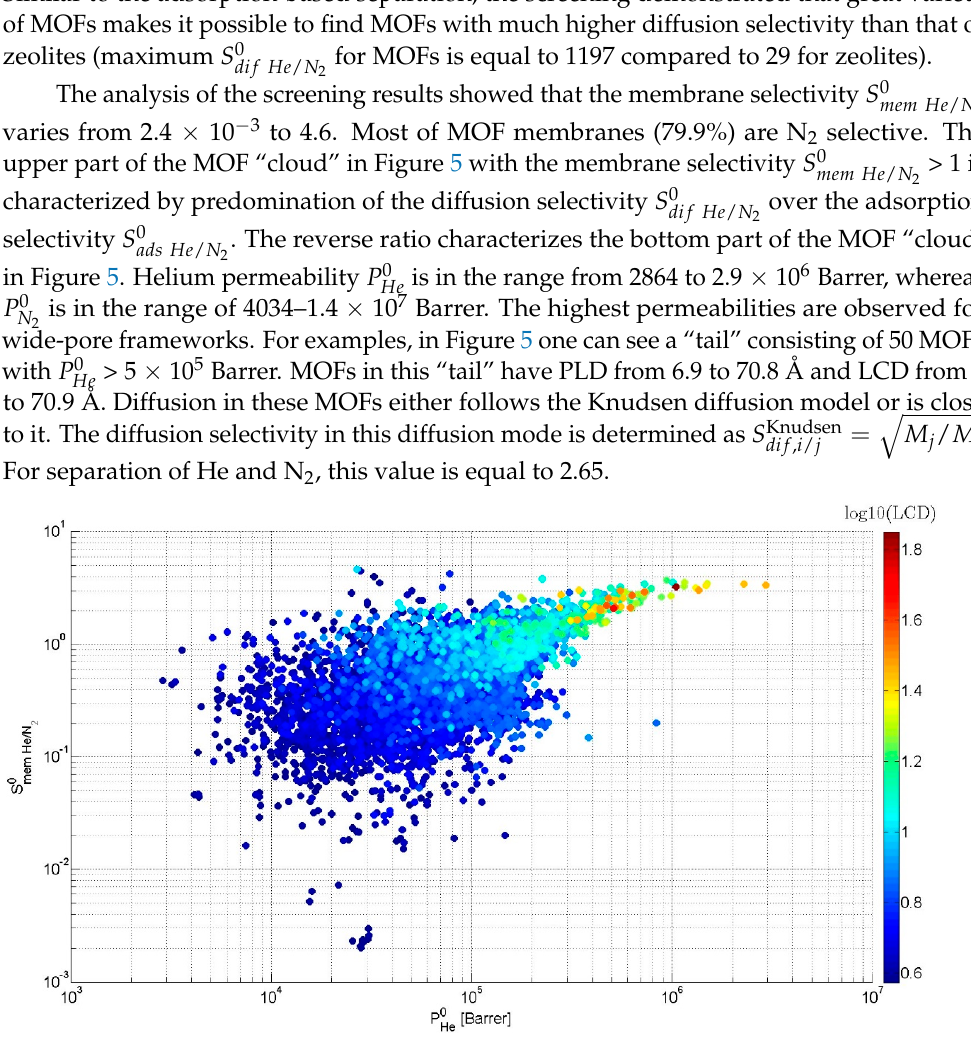
Figure 5. Dependence of membrane selectivity ( S 0 mined at infinite dilution and PLD.